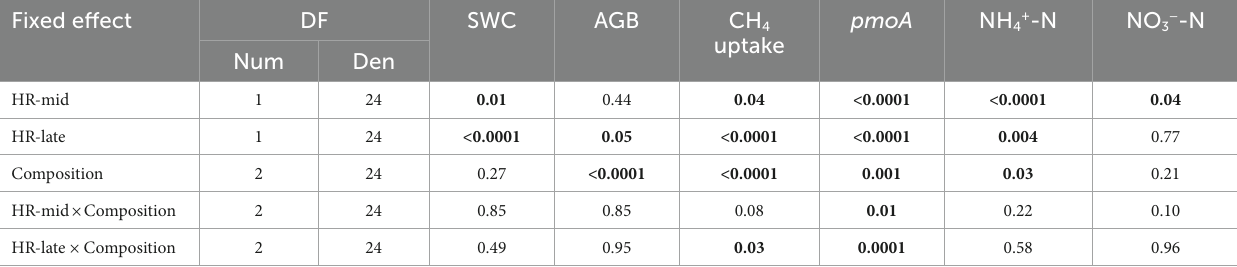
TABLE 1 p -Value from mixed-effect model analyzes of HR-mid and HR-late, community composition and their interactions on soil water content (SWC), aboveground biomass (AGB), CH 4 uptake, abundance of pmoA , and content of NH 4+ -N and NO 3 −